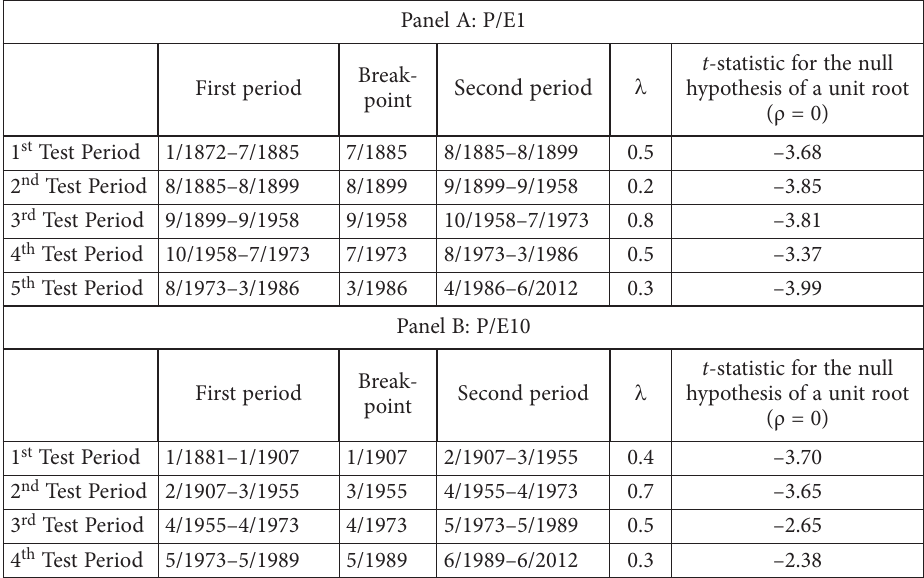
Table 2. Modified unit root test for structural breaks identified by the CUSUM method Panel A: